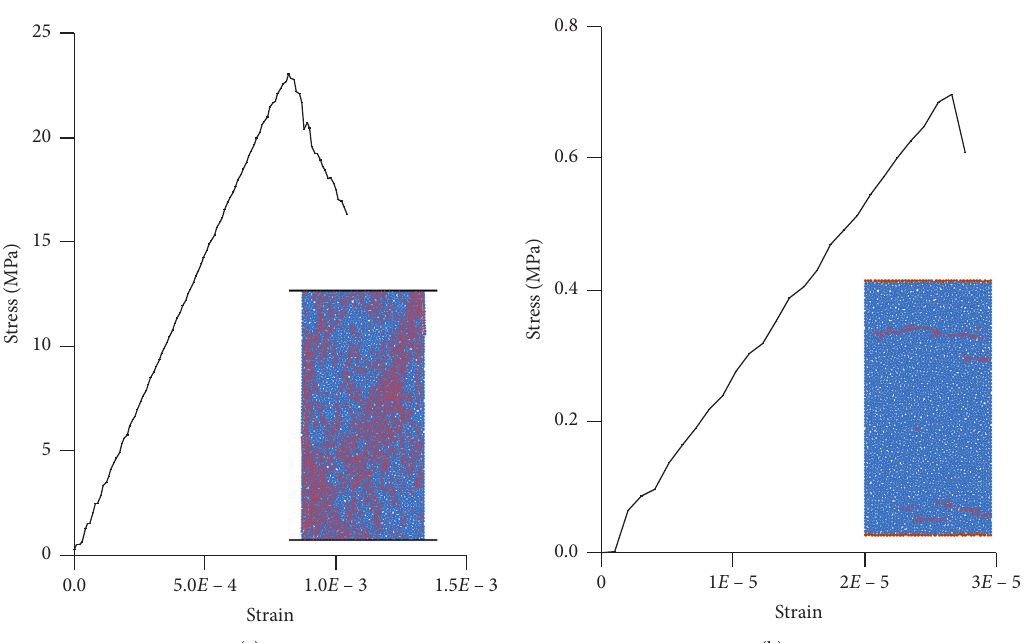
Figure 3: Numerical tests of the calibration parameters for the flat-jointed model. (a) Uniaxial compression test. (b) Tensile numerical test.